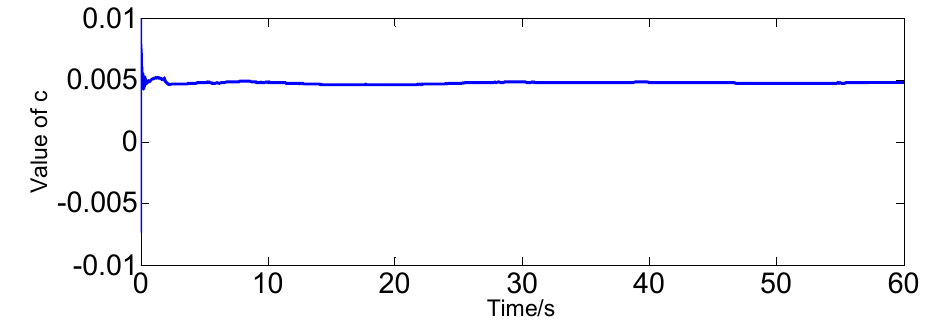
Figure 4. Real-time estimation of the parameter curve.